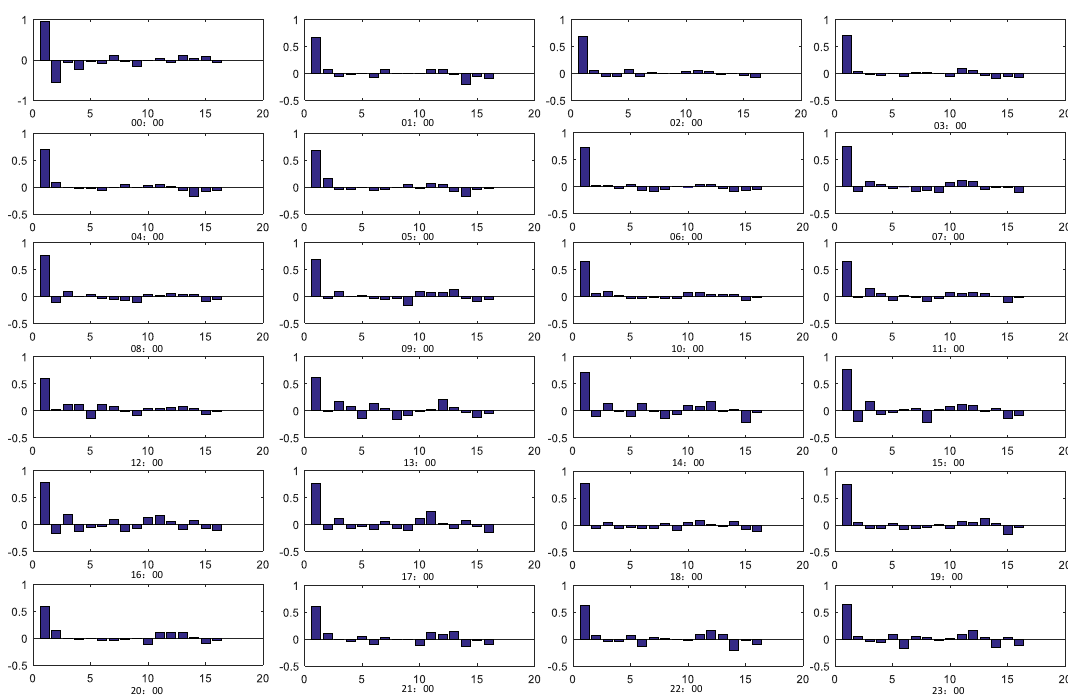
Figure 5. The partial auto correlation result of the load with the same interval.